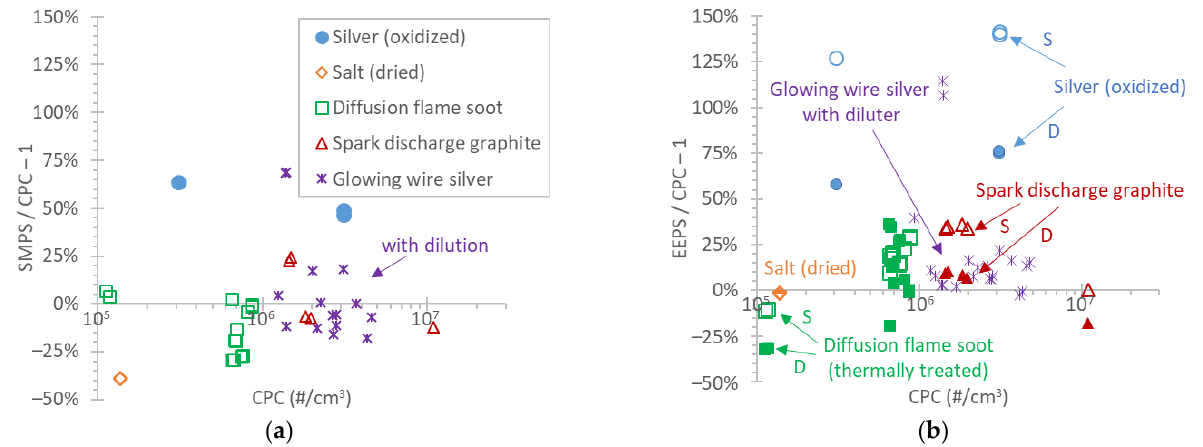
Figure 4. PN concentration ratio (SMPS or EEPS to CPC) in function of the CPC concentrations for various materials: ( a ) SMPS; ( b ) EEPS. “D” refers to the “Default” EEPS matrix (solid symbols), “S” refers to the “Soot” EEPS matrix (open symbols). CPC in photometric mode, except silver points indicated “with dilution”.